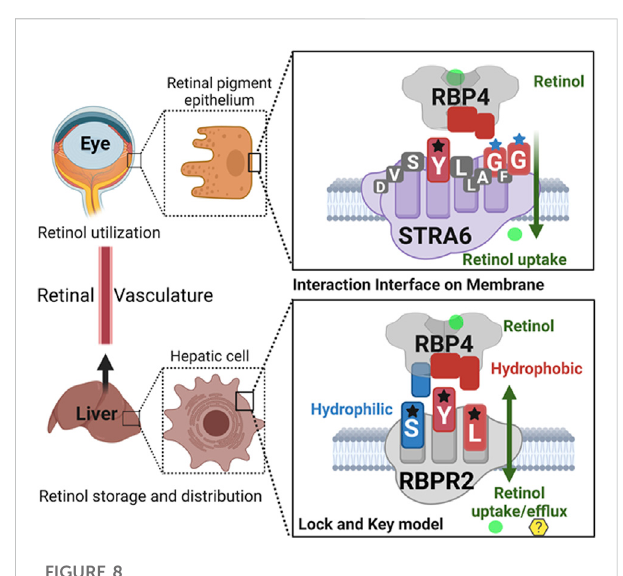
FIGURE 8 Schematic representation of the proposed RBP4 binding motif on RBPR2 for retinol uptake, storage, and distribution.Shown are the proposed RBP4 amino acid binding residues on STRA6 (YGG) and RBPR2 (SYL) that utilize a lock and key model mechanism to bind and stabilize the extracellular RBP4-retinol complex. The interaction interface between the membrane receptor and its ’ ligand is stabilized by both hydrophilic and hydrophobic interactions for retinol internalization. The proposedbindingresiduesforbothRBP4-ROLreceptorsarecolor-coded based on the property of the amino acid